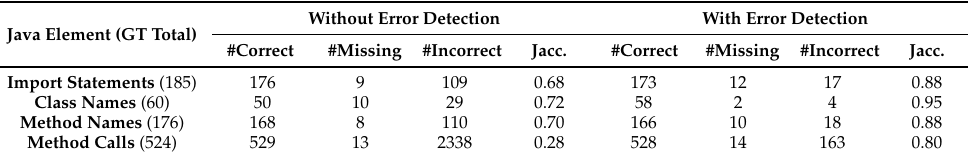
Table 5. The results of extracting Java elements from programming screencasts before and after applying the approaches to detect incorrect elements from the predicted code-editing window.